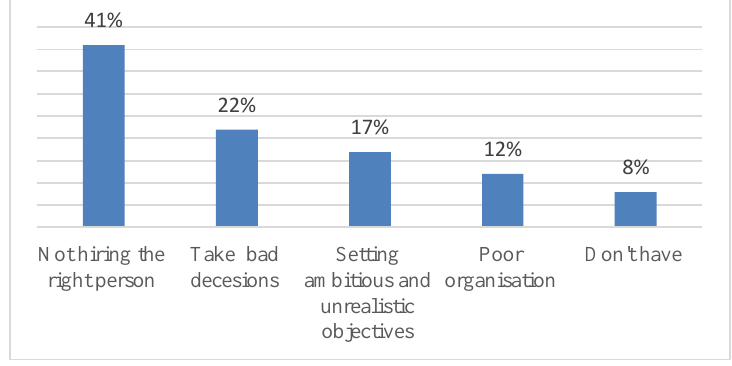
Figure 14: Startup Mistakes ; Source: